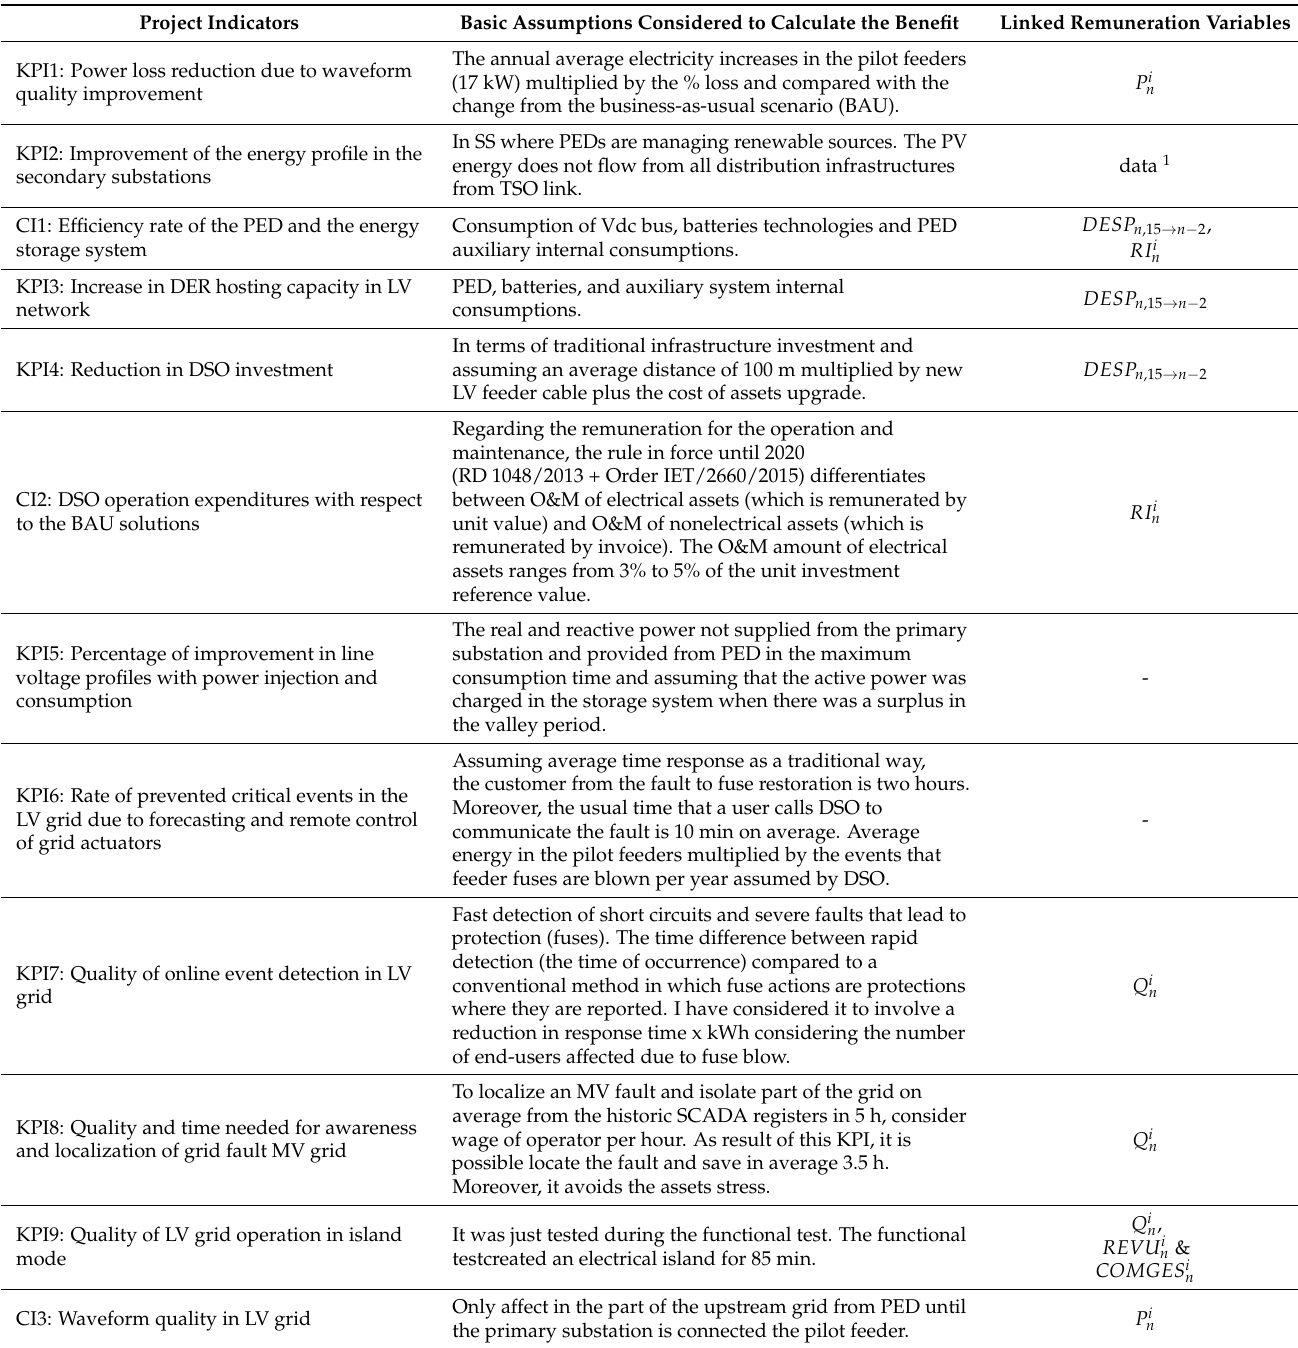
Table 2. Qualitative description of converting project indicators into benefits with linked remunera- tion